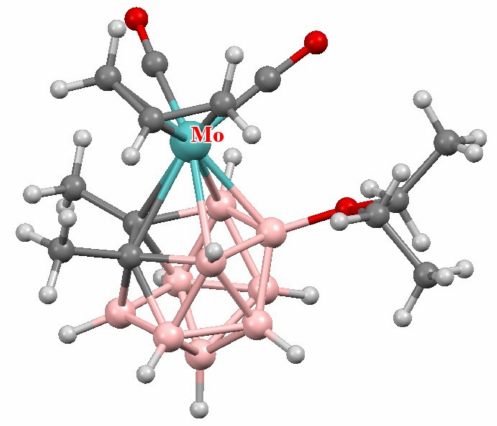
Figure 7. The molecular structure of [3-( η 3 -C 3 H 5 )-3-(CO) 2 -3-Mo(8-Et 2 O-1,2-Me 2 -1,2-C 2 B 9 H 8 )]. The reaction of a tetrahydrofuran derivative of the allyl dicarbonyl molybdenum com- plex [3-( η 3 -C 3 H 5 )-3-(CO) 2 -3-Mo(8-(CH 2 ) 4 O-1,2-Me 2 -1,2-C 2 B 9 H 8 )] with NEt 4 F or NBu 4 F in THF at room temperature led to the corresponding ammonium salts of [3-( η 3 -C 3 H 5 )-3- (CO) 2 -3-Mo(8-F-CH 2 (CH 2 ) 3 O-1,2-Me 2 -1,2-C 2 B 9 H 8 )] − . The treatment of tetraethylammo- nium salt of the obtained complex with HBF 4 .OEt 2 under an atmosphere of CO gave the charge-compensated tetracarbonyl molybdenum complex [3-(CO) 4 -3-Mo(8-F-CH 2 (CH 2 ) 3 O-